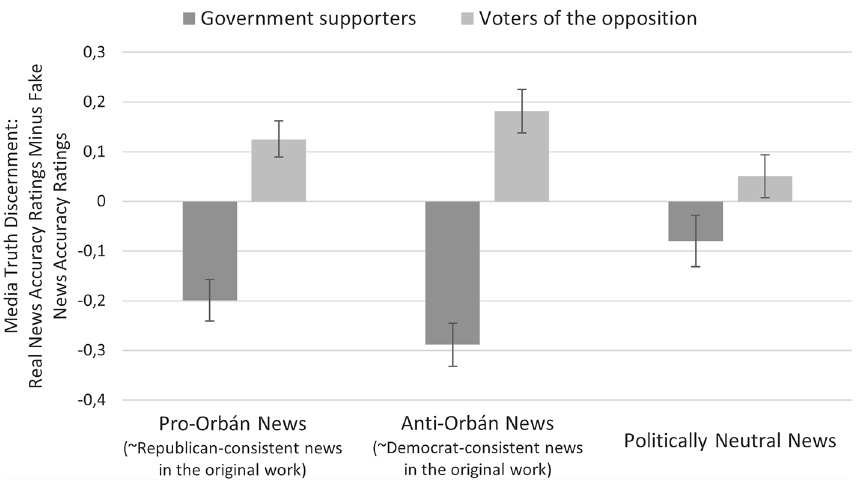
Figure 2. Media truth discernment as a function of political ideology and political leaning of the headline. Supporters of the opposition were considerably better at discerning fake from real news (irrespective of the type of news) than supporters of the government. Error bars represent 95% CIs. Note. High media truth discernment score indicates an increased capacity to distinguish real from fake news. “Government supporters” is rather similar to “Republican voters” in the context of the original work (and the US context) while “Voters of the opposition” is an analogy with “Democrat voters” in the Trump